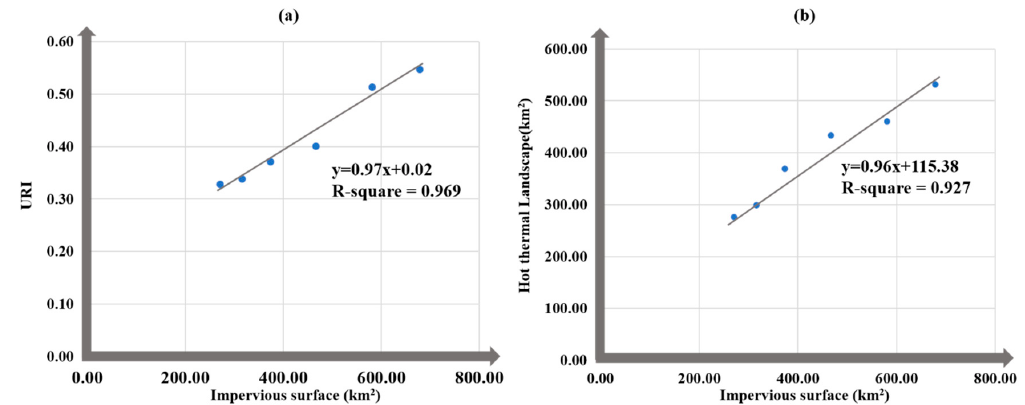
Figure 10. ( a )The relationship between IS and URI; ( b ) The relationship between IS and hot thermal landscape.